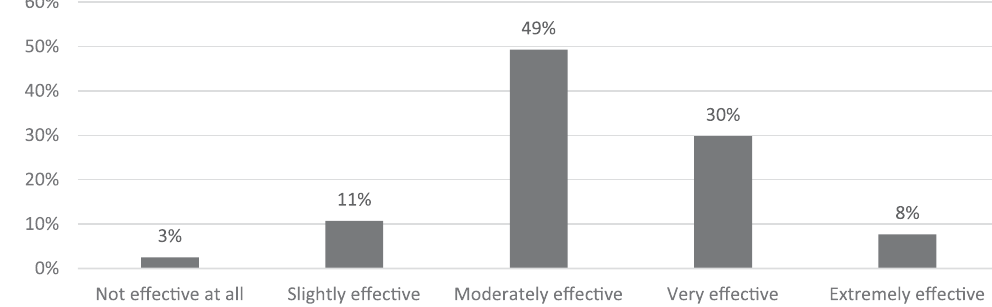
students.FIG. 2. Frequency distribution of perceived course effectiveness in engaging students majoring in life science